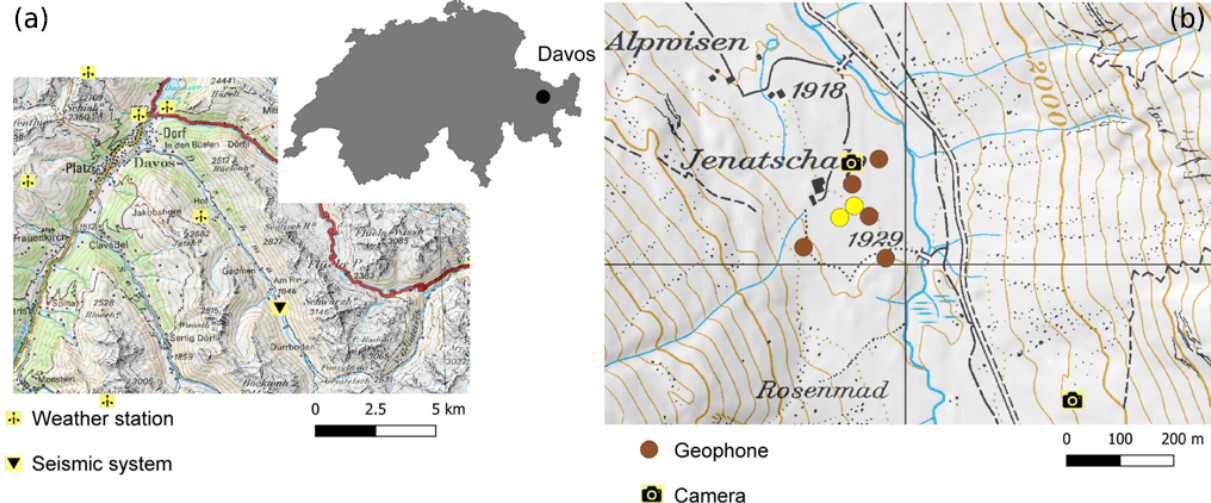
Figure 1. (a) Map of the Davos area, Switzerland. The location of the seismic system is shown by the black triangle; the wind wheel shows the locations of six of the seven the weather stations that provided input data for SNOWPACK. (b) Detailed map of the Jenatschalp site showing the geometry of the seismic array and the positions of automatic cameras. The yellow circles indicate the positions of sensors used in this study. Reproduced with permission from Swisstopo (JA100118).